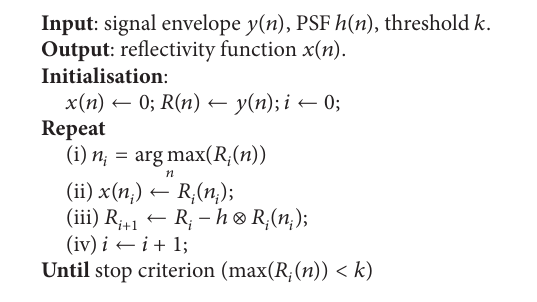
Algorithm 1: Noninverse greedy